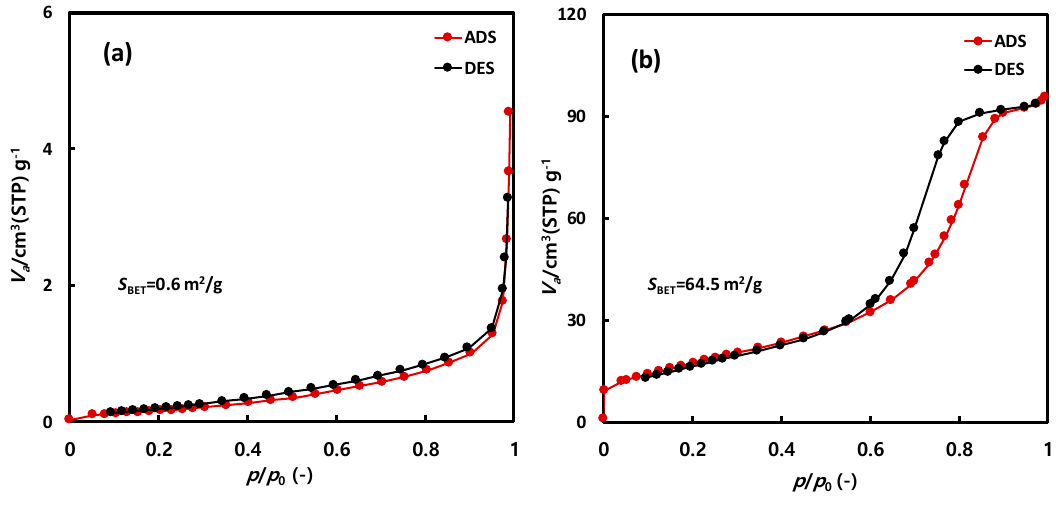
Figure 5. N 2 isotherm of ( a ) NNT-F and ( b ) NNT-P.